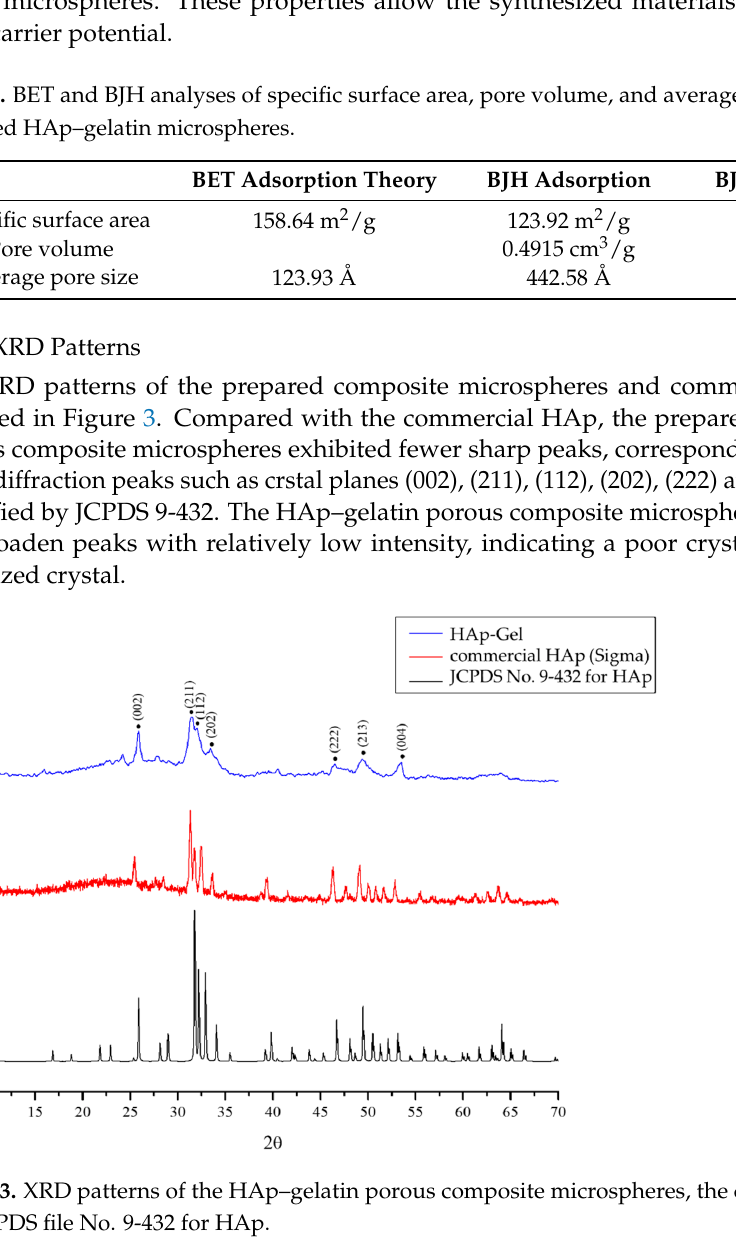
Figure 4. ( a ) UV–VIS spectrum of the DOX solution. ( b ) Calibration curve of absorbance at 480 nm versus the DOX concentration (ppm) in DI water. 3.2.2. Mechanisms of DOX Loading and Releasing DOX-loaded HAp composite microspheres were prepared in chitosan (Chi) solution at 37 °C for 48 h. A control sample containing only DOX and composite microspheres without chitosan powder was used to illustrate the effect of chitosan. In addition, the weight ratios of DOX to the HAp–gelatin porous composite microspheres to chitosan are 1:5:0, 1:5:0.125, 1:5:0.25, 1:5:0.5 and 1:5:1 corresponding to DL1, DL2, DL3, DL4 and DL5.